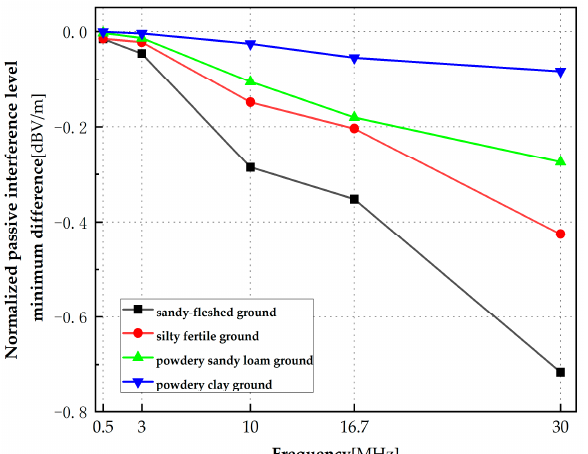
Figure 9. Normalized passive interference minimum value of four kinds of rough ground at different frequencies.